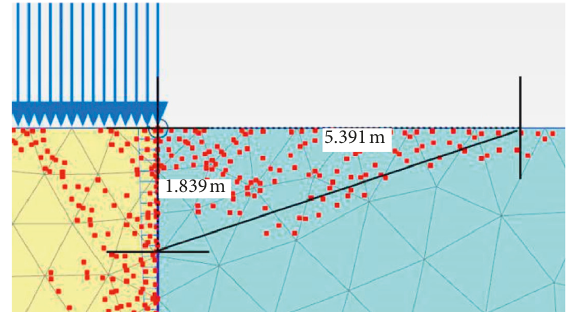
Figure 17: Distribution of failure points inside the foundation pit at φ � 45 ° .